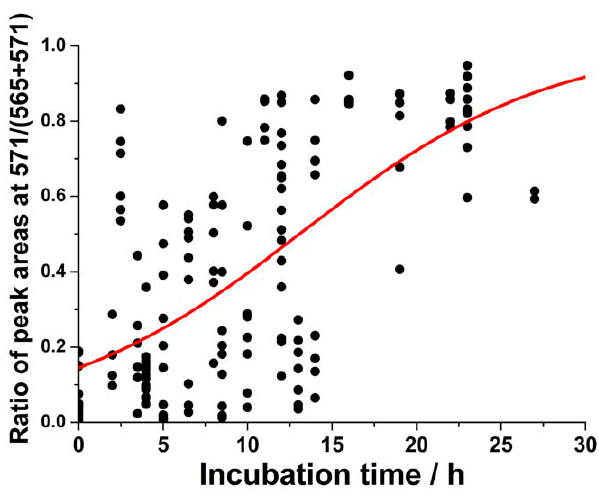
Figure 3. Progressive incorporation of the 13 C-label to UDP- glucose in fruit fly eggs. The data points were fitted with a sigmoid function: y =1.013 ? (1/(1 + e ( 2 0.135 x + 1.792) )). During this experiment, the flies were incubated with 13 C 6 -glucose and illuminated with white light ( , 4000 lux). Note that the sampling intervals (as projected onto the x - axis) are coincidentally not constant. doi:10.1371/journal.pone.0050258.g003 (UDP-glucose) is promptly labeled with 13 C, while the labeling of other metabolites – for example, adenosine triphosphate (ATP) – is much slower, and it does not reach completion during several days of incubation. The latter is concluded based on the presence of the non-labeled form of ATP after 19 days (the peak at the m/z 506 in Figure 2A ). Conversely, 13 C-labeled glucose can readily replace the unlabeled glucose moiety in the molecule of UDP-glucose.